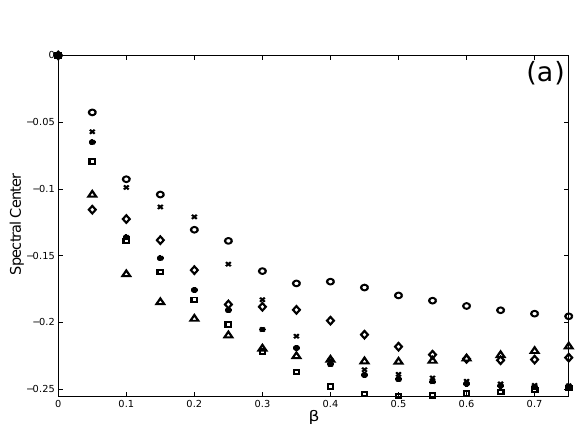
S ( t ) , (c) number of t [0 , 200] ∈